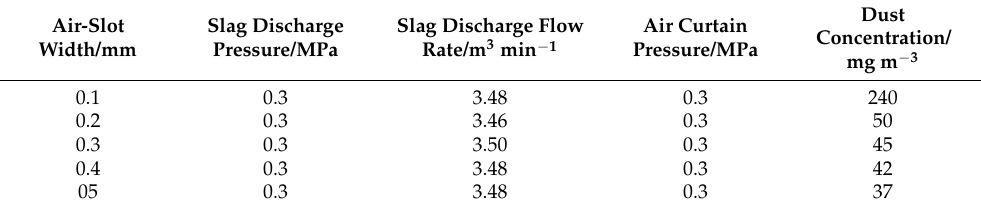
Table 2. The effect of air-slot width on dust control.